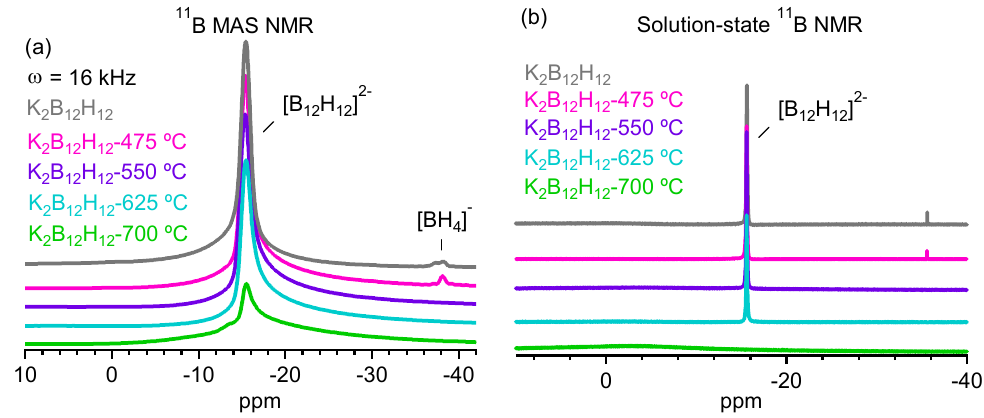
Figure 9. Ex-situ 11 B NMR spectra of anhydrous K 2 B 12 H 12 as synthesized and heated up to respective temperatures: ( a ) solid-state 11 B MAS NMR spectra and ( b ) solution-state 11 B NMR spectra measured in DMSO-d 6 . Resonance assignments: –15.6 ppm [B 12 H 12 ] 2 − , –35.6 ppm [BH 4 ] − [32].